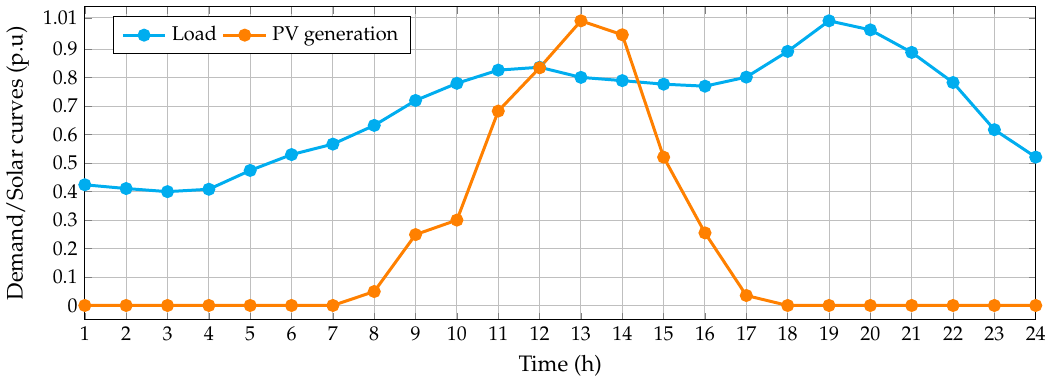
Figure 5. Behavior of the photovoltaic (PV) generation and the demand during a typically operation day [21].